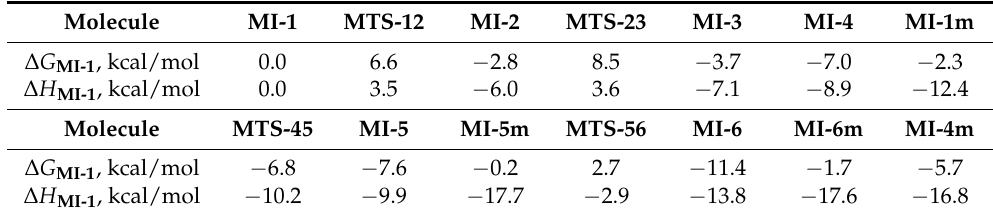
Table 1. Calculated ∆ G MI-1 and ∆ H MI-1 values for the key intermediates and transition states for the mononuclear mechanism of MeOEP